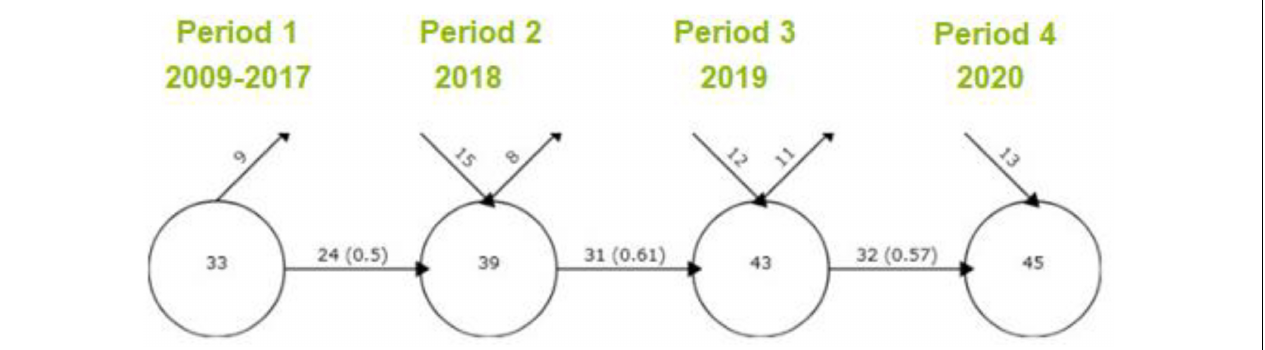
FIGURE 3 | Keywords between periods. Source: Own elaboration with SciMAT.